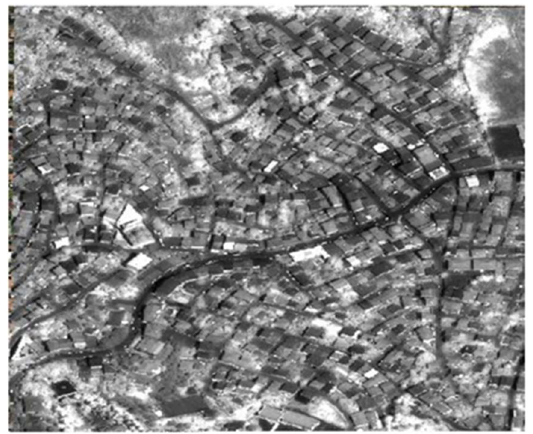
Figure 2: RGB bands image